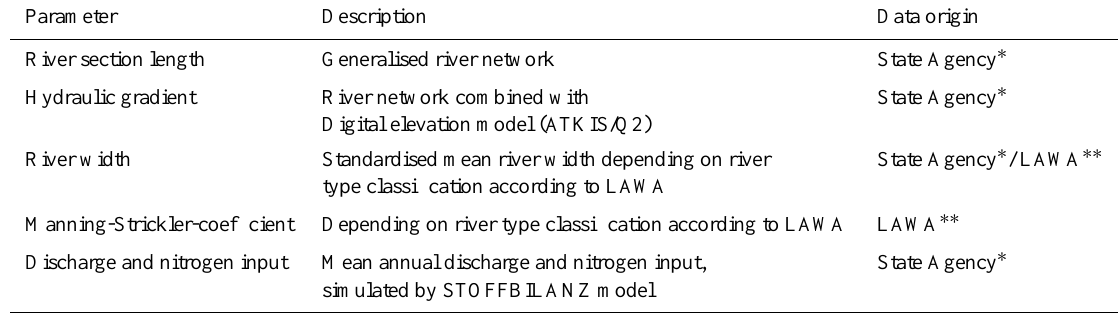
Table 1. Model parameters and calibration